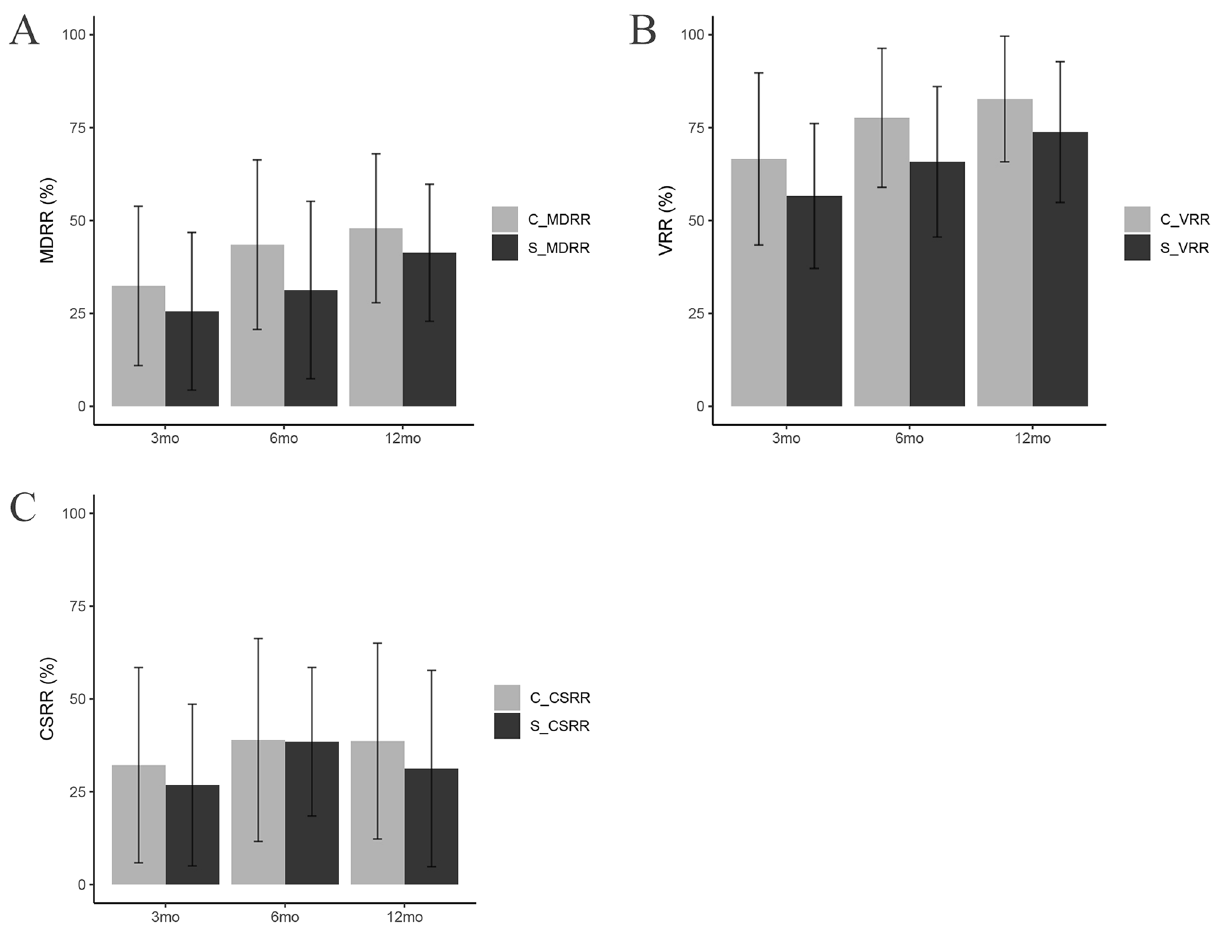
Figure 6. The comparison of the ablated nodular MDRR/VRR/CSRR between the solid and cystic-solid nodule group at each follow-up. ( A ) The comparison of maximal diameter reduction ratio between the two groups. ( B ) The comparison of volume reduction ratio between the two groups. ( C ) The comparison of cosmetic scores reduction ratio between the two groups. Means ± SD are demonstrated. p < 0.05 was considered to indicate statistically significant difference ( MDRR maximal diameter reduction ratio, VRR volume reduction ratio, CSRR cosmetic scores reduction ratio, S _ solid nodule group, C _ cystic-solid nodule group, BA baseline, mo nodules. The cystic fluid was aspirated before ablation, which may artificially accelerate the process of nodular shrinkage. Hence, the decline peak of nodular maximum diameter and volume appears in advance, synchronized with the cosmetic score. These results suggest that cystic-solid nodules shrank obviously at 6 mo after RFA. In order to further compare the efficiency of the two groups after ablation, MDRR, VRR and CSRR were also selected as study subjects. The mean MDRRs of the solid group vs. the cystic-solid group at the 3rd, 6th, 12th month were 25.58 ± 21.21% vs. 32.40 ± 21.43% (p = 0.003), 31.30 ± 23.87% vs. 43.51 ± 22.82% (p < 0.010), 41.33 ± 18.44% vs. 47.92 ± 20.04% (p = 0.229), respectively (Fig. 6A).The mean VRRs of the two groups at the 3rd, 6th, 12th month were 56.61 ± 19.50% vs. 66.58 ± 23.16% (p < 0.001), 65.81 ± 20.24% vs. 77.65 ± 18.70% (p = 0.005), 73.81 ± 18.94% vs. 82.71 ± 16.90% (p = 0.106), respectively (Fig. 6B).The mean CSRRs of the two groups at the 3rd, 6th, 12th month were 26.80 ± 21.77% vs. 32.16 ± 26.30% (p = 0.031), 38.48 ± 20.00% vs. 38.94 ± 27.33% (p = 0.915), 31.25 ± 26.44% vs. 38.64 ± 26.37% (p = 0.335), respectively (Fig. 6C). The mean nodular MDRRs and VRRs at the 3rd, 6th months showed significant difference between the two groups, but at the 12th month, statistical significance was not found, and the cystic-solid group had a higher MDRR and VRR than that in the solid group. Between the two groups, there was no significant difference in the mean CSRR at the 6th, 12th month. While at the 3rd month of the follow-up, statistical significance was found, and the cystic-solid group had a higher CSRR than that in the solid group. Those results above may be attributed to different ablation method and transformation of nodular nature. The aspiration of cystic fluid could artificially increase the reduction ratio of cystic-solid nodules, which was higher than that of the solid nodules. Six months after ablation, cystic-solid nodules can completely convert into solid nodules, giving rise to no significant difference at 12 mo. Therefore, the 6 mo can be regarded as the confluent point of cystic-solid and solid nodules. Previously, the decrease rate of the two groups was different from each other, owing to their diverse composition. While after 6 months, the two groups performed synchronous rate of change due to the shift from cystic-solid to solid, and we can see that the difference was not significant at 12 mo.